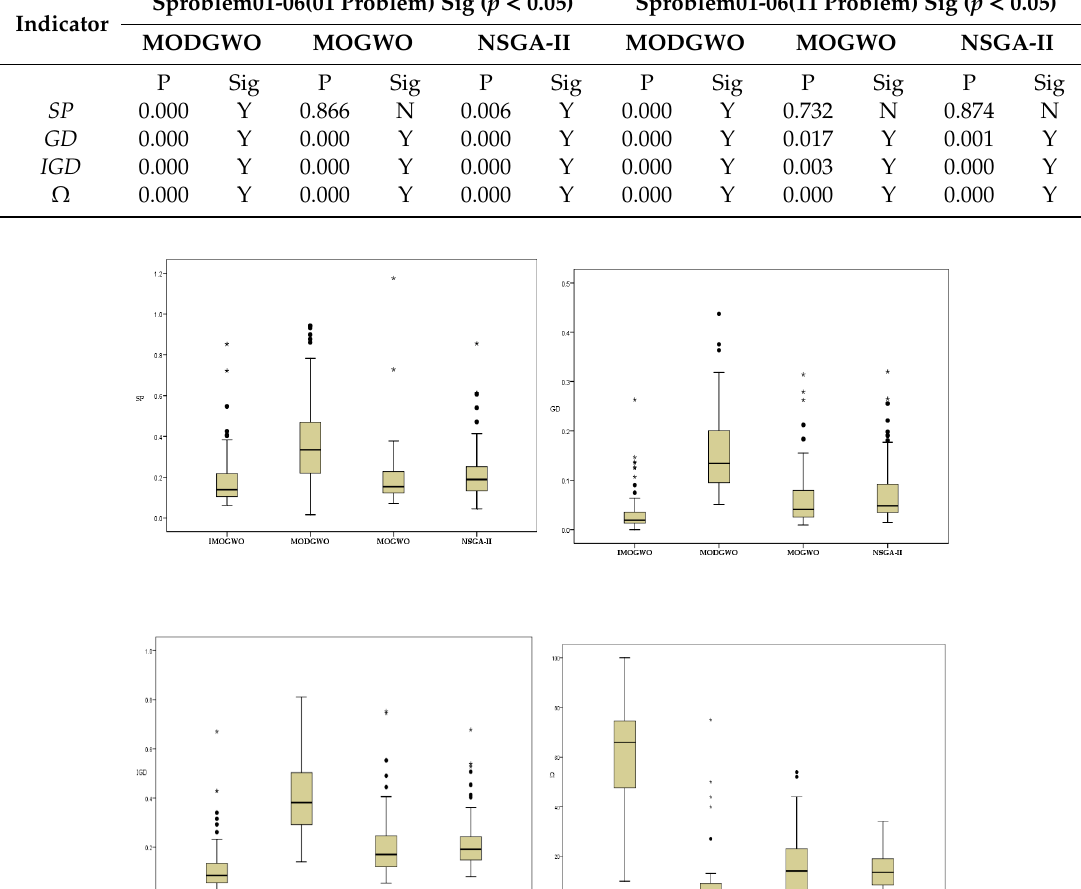
Figure 6. Box-plots of four evaluation indicators for three factories’ test cases.